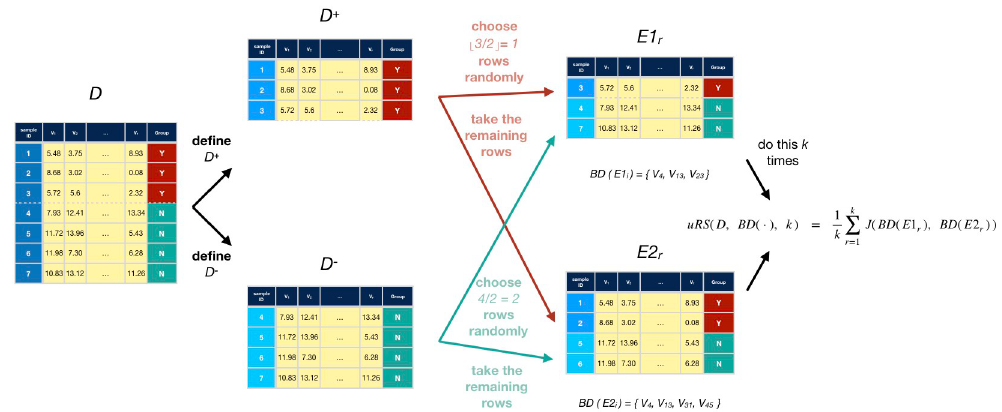
Fig 3. Computing uRS. Diagram showing uRS’s process of generating pairs of subsets for a dataset D ( k times), then using those to compute uRS(D, BD( � ), k).